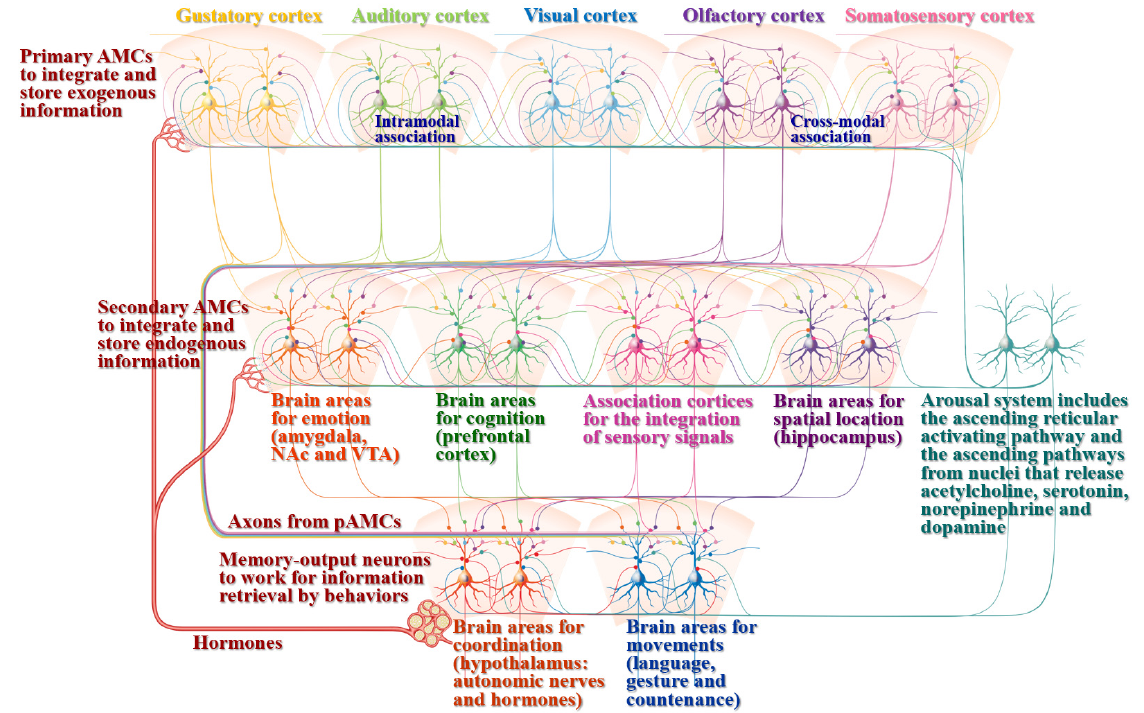
Figure 2. Associative memory cells and their working principles in the memory, cognition and emotion. Associative learning and memory include the acquisition of associated signals, the integration and storage of exogenous signals, the integration and storage of endogenous signals, as well as memory retrieval through behavioral presentation. Associative memory cells (AMCs) are classified into primary AMCs (pAMCs) in sensory cortices, including visual, auditory, olfactory, gustatory and somatosensory cortices for the integrative storage of exogenous associated signals, as well as secondary AMCs (sAMCs) in brain areas related to cognitive processes (logical reasoning, associative thinking, computation, imagination, concept, judgement conclusion, decision and so on in the prefrontal cortex), emotional reactions (fear, aversion, happiness, angry and so on in the amygdala, ventral tegmental area (VTA) and nucleus accumbens (NAc)), sensation integration (understanding and perception in association cortices) as well as spatial localization in the hippocampus. pAMCs are mutually connected through cross-modal and intramodal synapse innervations for the integrative storage and the reciprocal retrieval of associated signals. The axons of pAMCs convergently innervate onto sAMCs for cognition, emotion and spatial localization. sAMCs are mutually connected through their synapse innervations for the integration of cognition, emotion, perception, localization and so on. All of these primary and secondary associative memory cells will send their axons toward brain areas relevant to behaviors (language, gesture and countenance in motion cortices) and their coordination (the systems for maintaining internal environment, e.g., the hypothalamus to control autonomic nerves and hormones). Cross-modal associative memory cells are recruited by mutual innervations among sensory cortices or between cognition- and emotion-relevant brain areas. Intramodal associative memory cells are recruited by mutual innervations among the neurons in single-modality sensory cortex, cognition brain area or emotion brain area. In addition to the activation by innate input and new synapse innervation from the coactivated brain regions to integrate and encode associated signals, associative memory cells are activated by the arousal system, including the ascending reticular activating pathway in the brain stem and thalamus as well as the ascending activating pathways from the cholinergic nuclei, midbrain raphe nuclei, locus coeruleus and substance nigra that release acetylcholine (ACh), serotonin (5-HT), norepinephrine (NE) and dopamine (DA), respectively, which can maintain wakefulness, permit normal consciousness as well as grant specific alertness and attention. In addition, associative memory cells are regulated by hormones that are released from the hypothalamus-pituitary-glands. The upregulations of AMC number and activity strength can facilitate